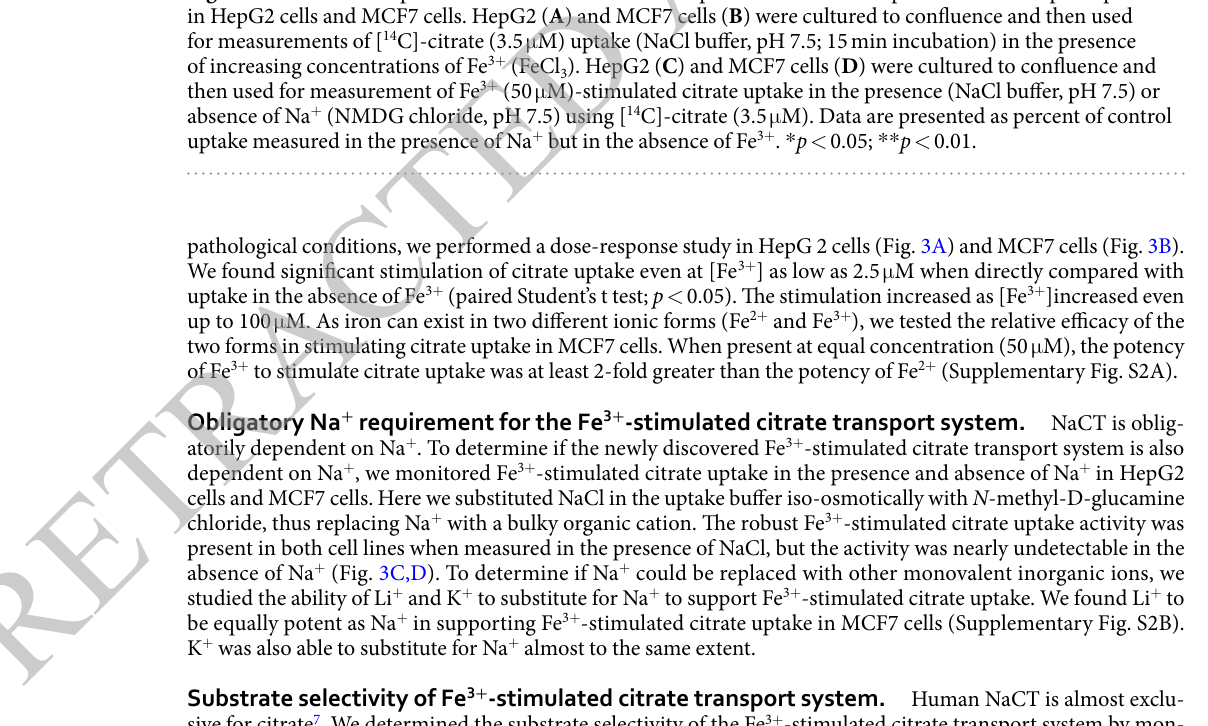
be equally potent as Na + in supporting Fe 3 + -stimulated citrate uptake in MCF7 cells (Supplementary Fig. S2B). K + was also able to substitute for Na + almost to the same extent.